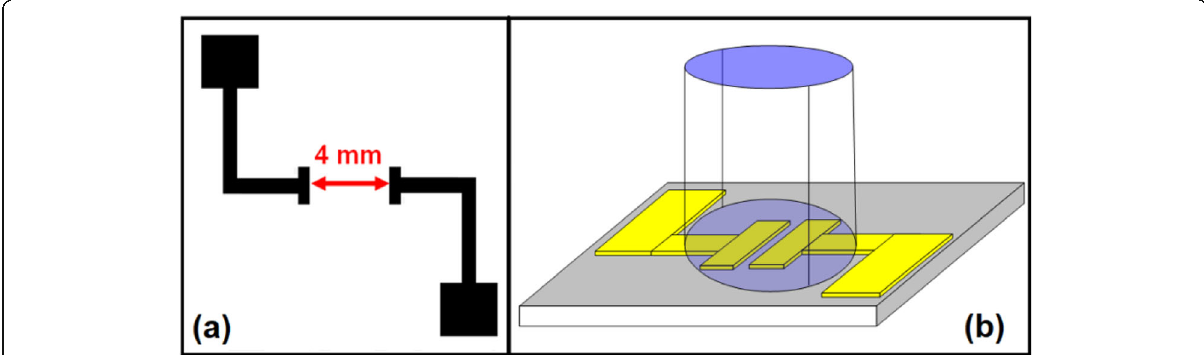
Fig. 1 a Microelectrode design pattern used. b Customized cell-culture chamber